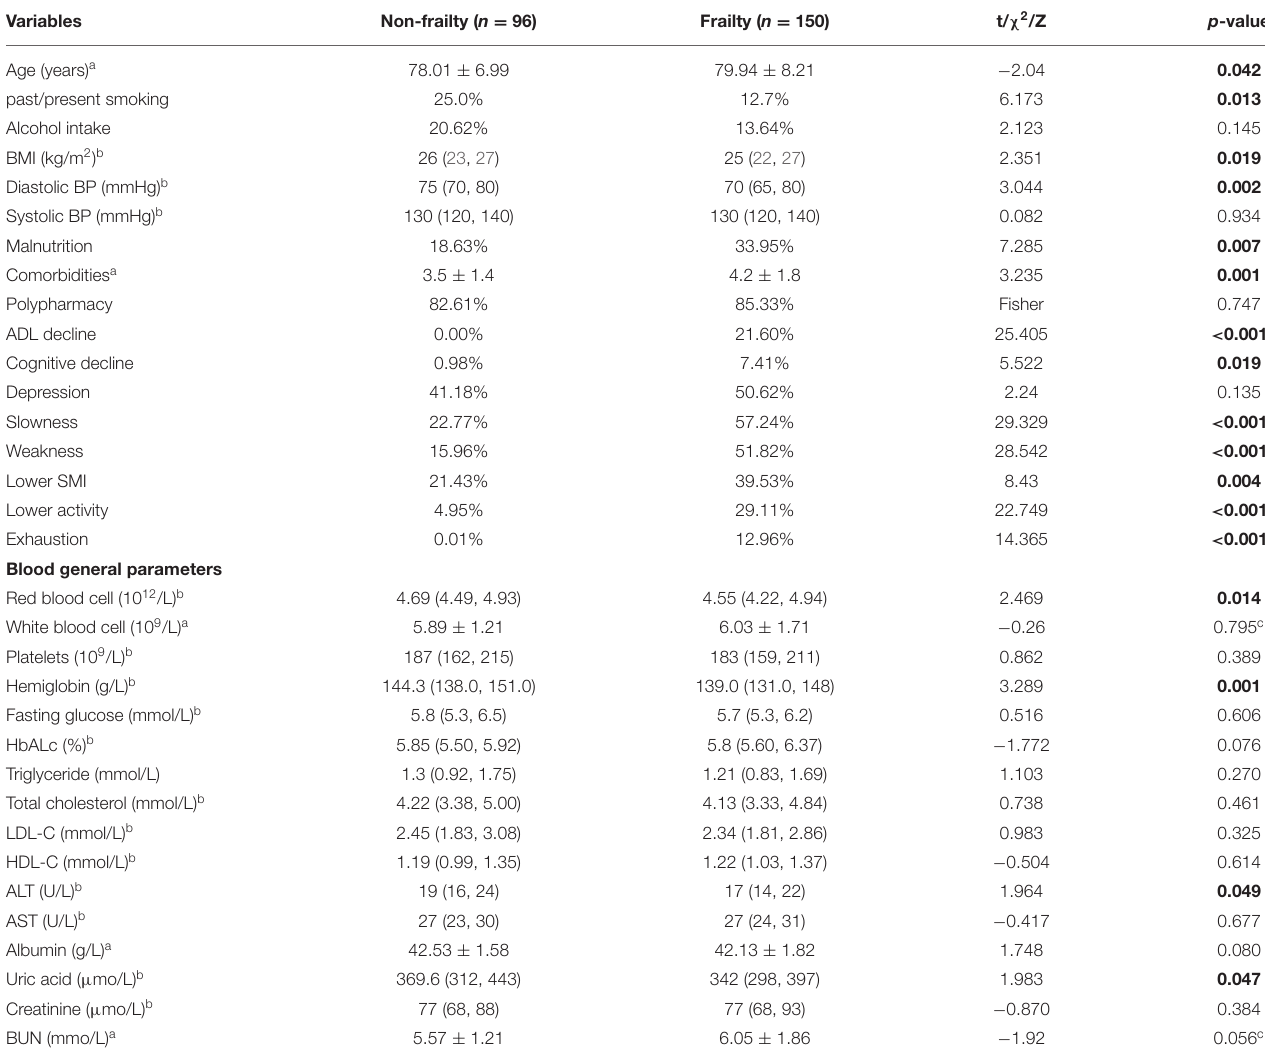
TABLE 1 | Clinical characteristics of elderly individuals with frail and non-frail status. Variables Non-frailty ( n = 96) Frailty ( n = 150) t/ χ 2 /Z p -value